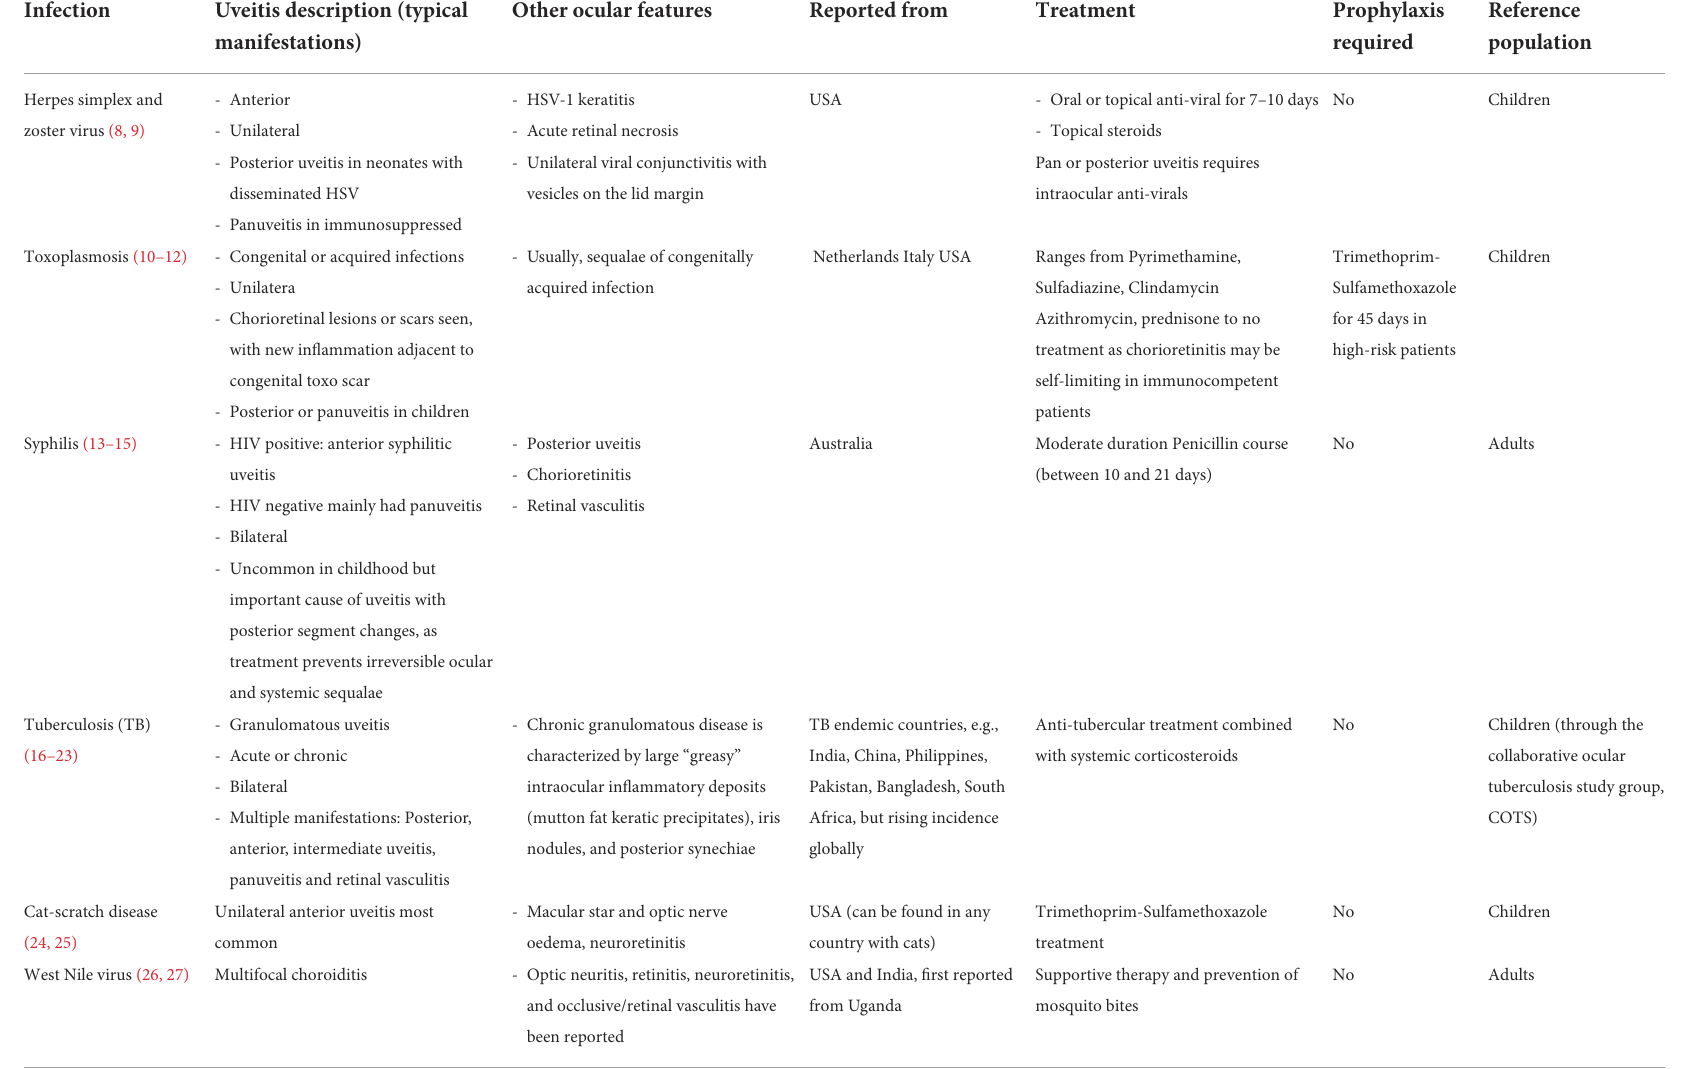
TABLE 2 Infectious uveitis in